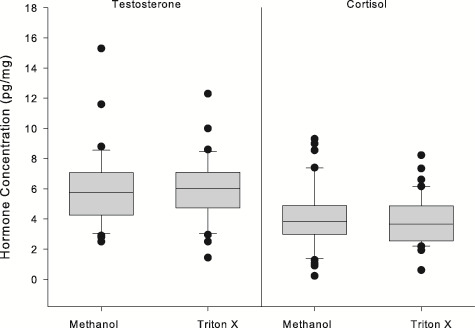
Comparison of the concentration of testosterone (n = 32) and cortisol (n = 40) in paired samples after being processed using two washing methods: methanol and TritonTM X-100. Box plot: grey box includes data between the 25th and 75th percentile, with a line within each box denoting the median, the whiskers denote the error bars (10 and 90% percentile), and the circles denote outliers